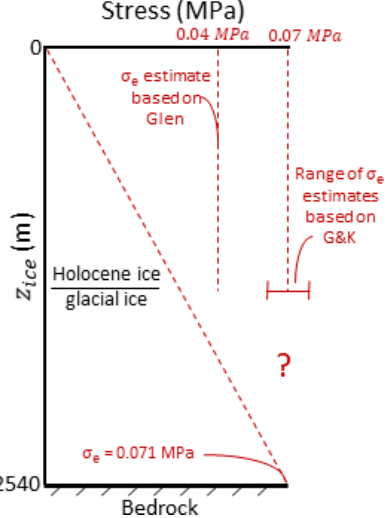
Figure 6. The equivalent shear stress ( σ e ) with depth calculated us- ing the shallow ice approximation (Eq. 11) and the range of the estimated longitudinal stress, based on the modified parameters of the composite flow law (G&K) of Table 2 and the best estimate for Glen’s flow law constrained by the annual layer thinning in the Holocene ice of the NEEM ice core. There are no constraints on the annual layer thinning in the Glacial and Eemian ice, which is indicated by the question